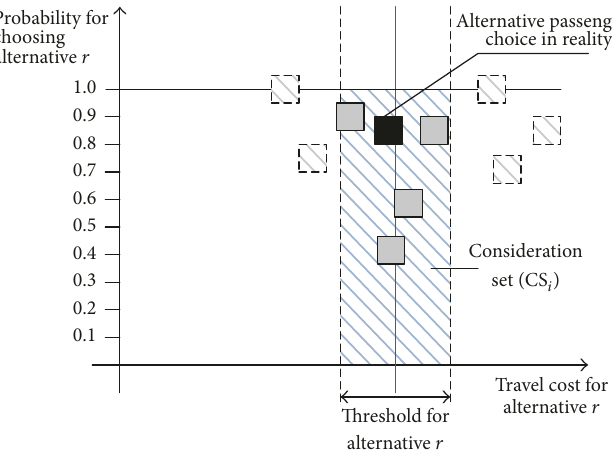
Figure 2: Formulating the estimation problem of URT passenger train